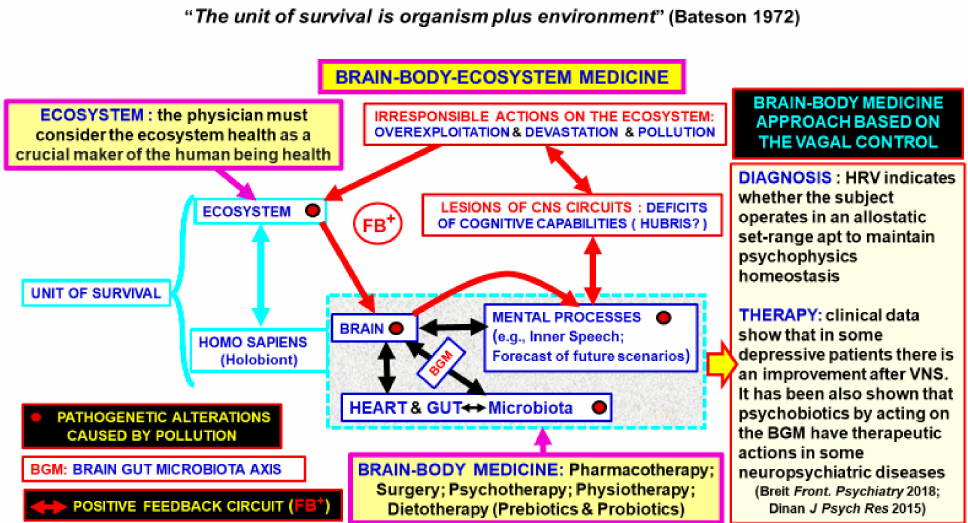
Figure 4. Schematic representation of the basic assumptions of the brain-body-ecosystem medicine model: The physician must consider the ecosystem health as a crucial component of human beings health and the brain-body medicine approach based on the vagal control can be of paramount diagnostic importance to detect disturbances of the physical and psychic homeostasis of the